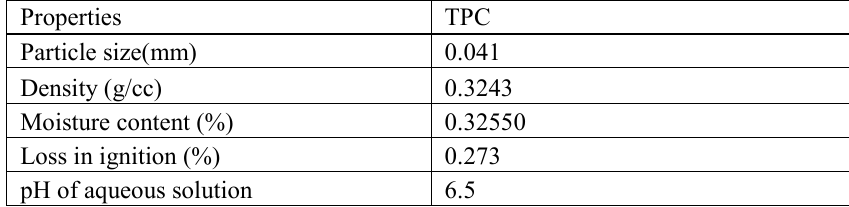
Table 1. Characteristics of the Adsorbent.